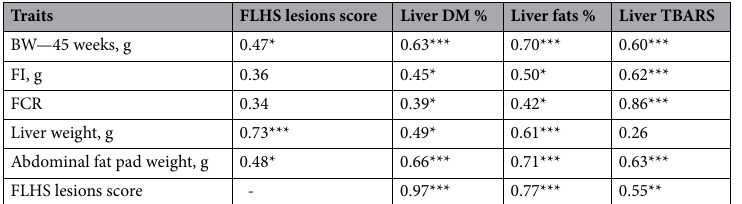
Table 4. Correlations ( r ) of liver tissue characteristics, organ parameters and performance traits of individually housed ISA Brown hens aged 45 weeks. BW, body weight; FI, feed intake; FLHS, fatty liver